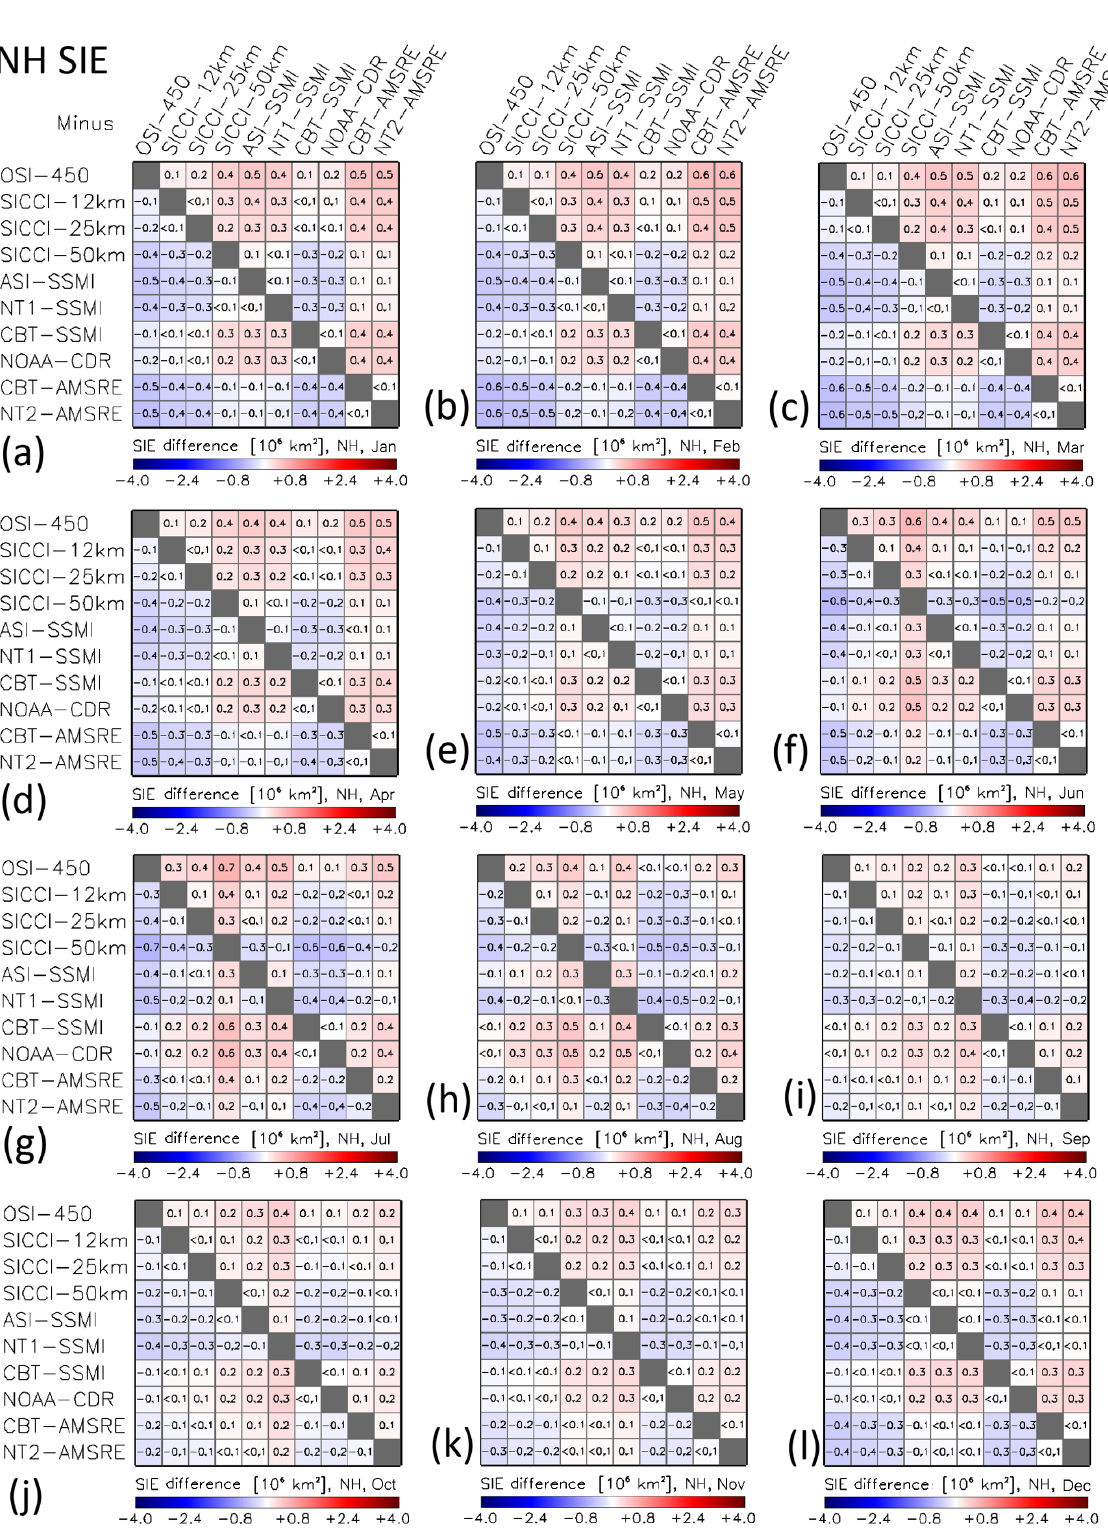
Figure G3. Differences between all 10 products of the average sea-ice extent (SIE) for the Arctic. The differences are computed from monthly mean SIE of the respective months of the AMSR-E period June 2002 to September 2011. All data are on the EASE-Grid 2.0 with 50km grid resolution. The land mask of the SICCI-50km product is applied to all products.